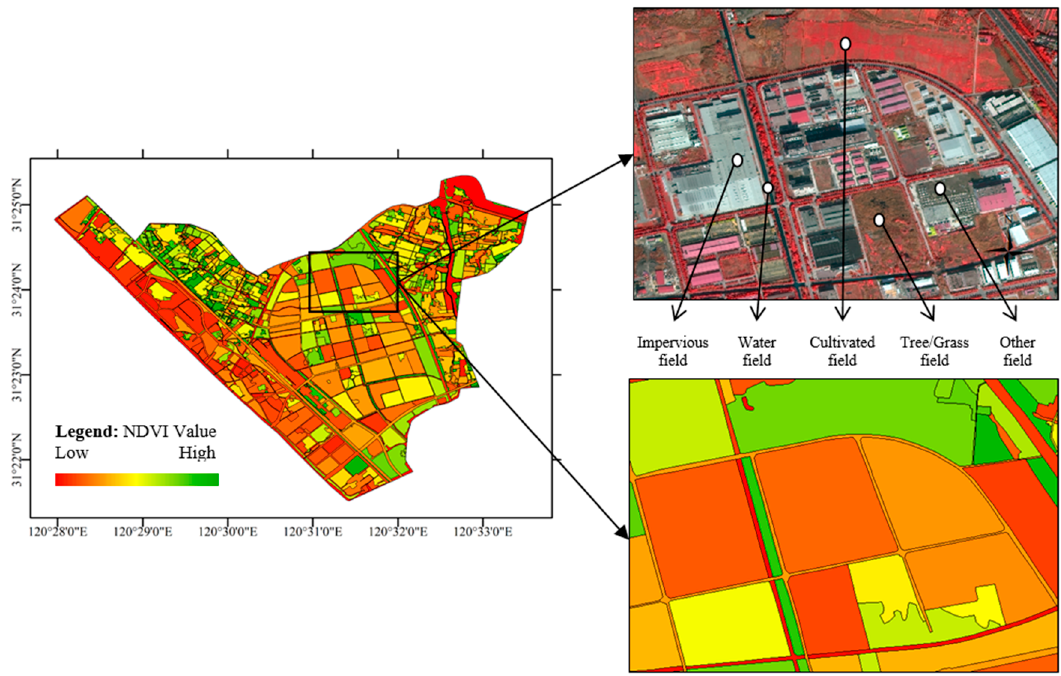
Figure 5. Instances of the NDVI feature for the selected LC types with the units of geo-objects. Table 2. List of geo-object features used in ML.